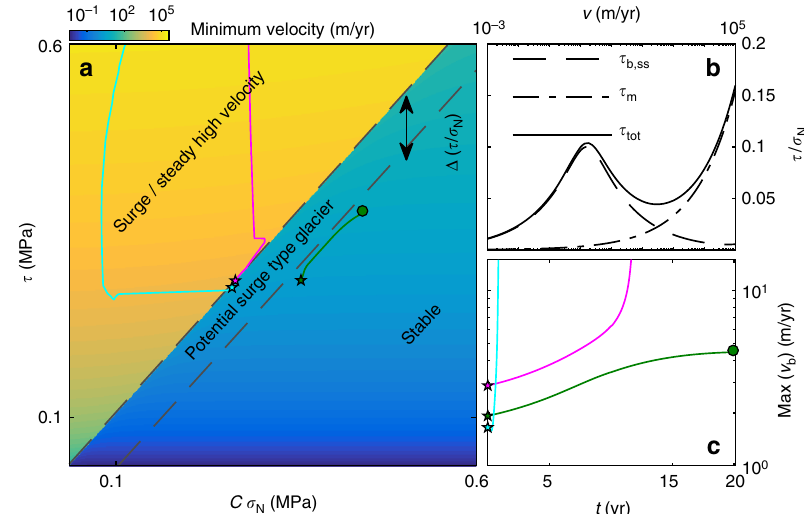
Fig. 4 Combined basal and lateral drag is velocity-strengthening at low velocities, velocity-weakening at intermediate velocities, and velocity-strengthening at high velocities. The smallest possible sliding velocity that can support a driving stress τ for a given C σ N ( a ) derived from the steady state sliding law including stress from the glacier margins ( b ) given C * = 0.1, and the driving stress for A s = 100 m yr − 1 MPa − 3 , n = 3, m = 3, A = 15 yr − 1 MPa − 3 , W = 1.5 km, q = 2.0 and σ n = 3.5 MPa (Supplementary equation 15). τ b,ss is the basal shear stress, τ m is the stress from the margins, and τ tot is the total shear stress. The steady state velocity in a demonstrates a discontinuity from slow sliding regime dominated by basal friction to a fast sliding regime where shear stress is carried at the glacier margins. Surges can be triggered if the line of stability (black dashed line) is crossed in a suf fi ciently large region of the glacier bed given by L critical (details in the text). Colored lines show the driving stress τ and C σ N at the position at the base with the largest value of τ (excluding the up-glacier propagation). c The maximum basal velocity for the simulations shown in a . All simulations were performed with q = 2.0 and d c = 1.0 m, but with different values of C *. Magenta: C * = 0.25e x /2000m + 0.08 (System studied in main text). Green: C * = 0.25e x /2000m + 0.12, Cyan: C = 0.3 with a full hydrology model triggered by an increase in meltwater supply at the base (details in Supplementary Information methods and Supplementary Figure 8 and Supplementary Figure 9)